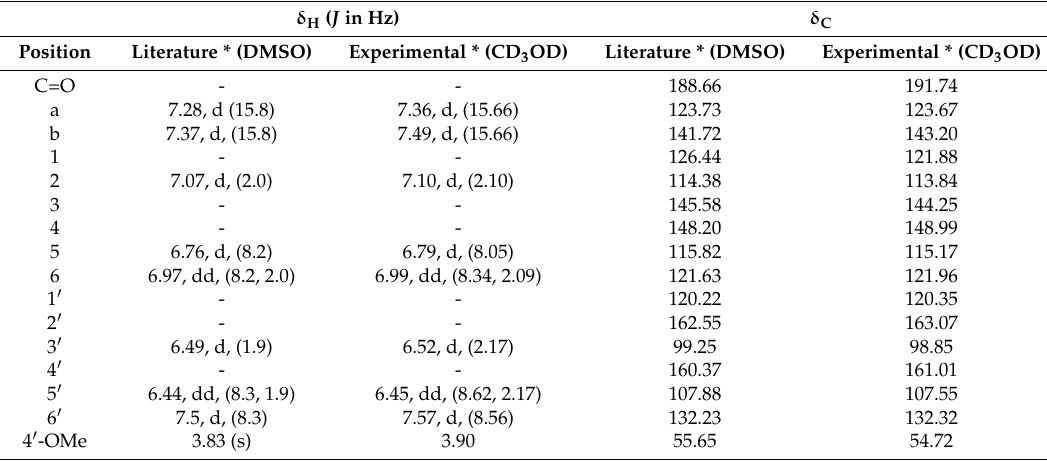
Table 4. 1 H-NMR and 13 C-NMR data for calythropsin ( 5 ) [17].